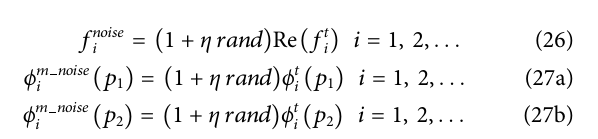
Frontiers in Built Environment |